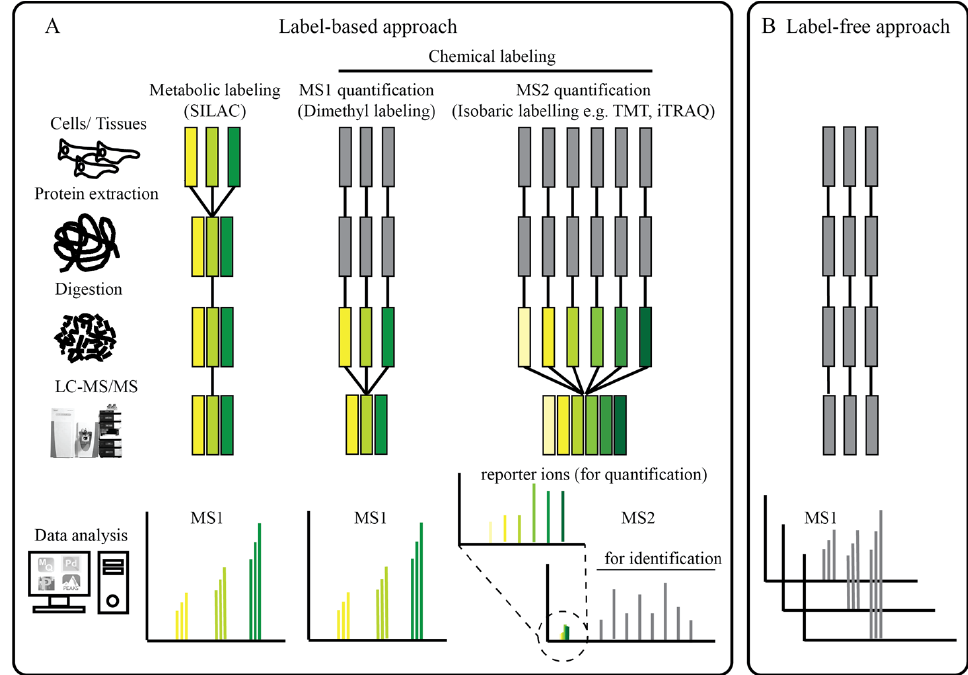
Figure 2. General depiction of various strategies in quantitative proteomics. ( A ) Label-based ap- proaches include the incorporation of stable isotope labels at different steps of sample preparation. The labeled samples are mixed in an equivalent ratio and analyzed in a single LC-MS/MS run. For SILAC and dimethyl labeling, the quantitation is performed by comparing the differences in the ion intensity of the labeled peptide pairs. For the isobaric labeling approach, the quantitation is based on the comparison of reporter ion intensities. ( B ) In the label-free approach, samples are separately prepared and subjected to individual LC-MS/MS runs. Quantification is achieved by run-to-run comparison of the integrated ion intensity or spectral counting.